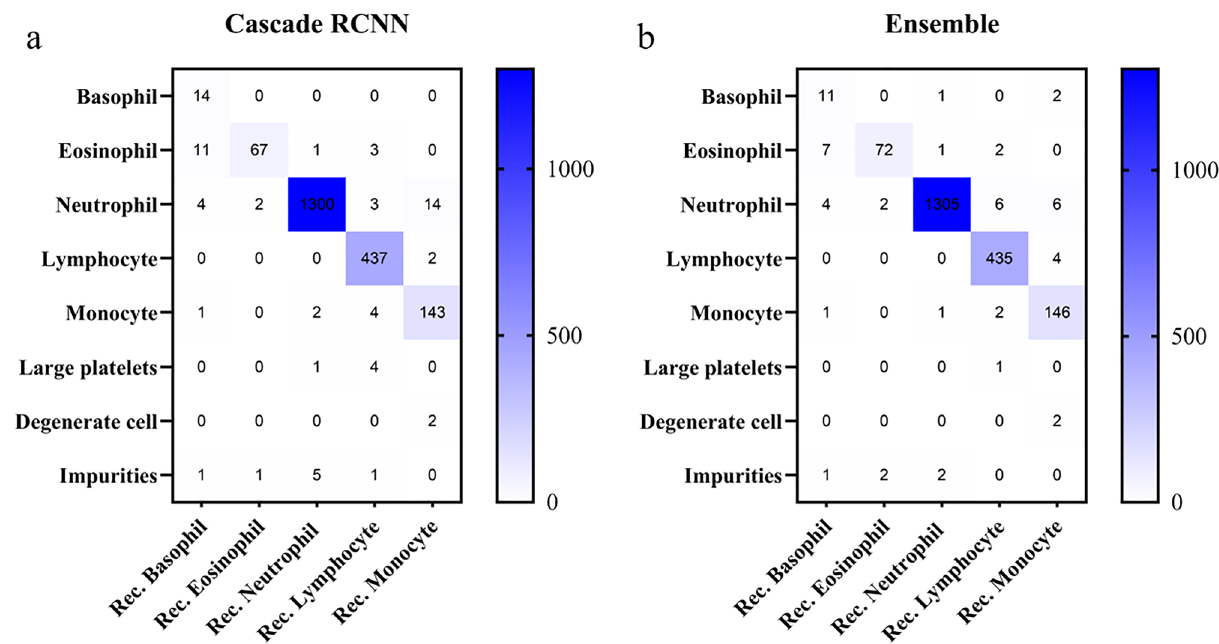
Figure 6. The heat map of the confusion matrix for the Cascade R-CNN and the ensemble model’s performance detecting five types of leukocytes on the test